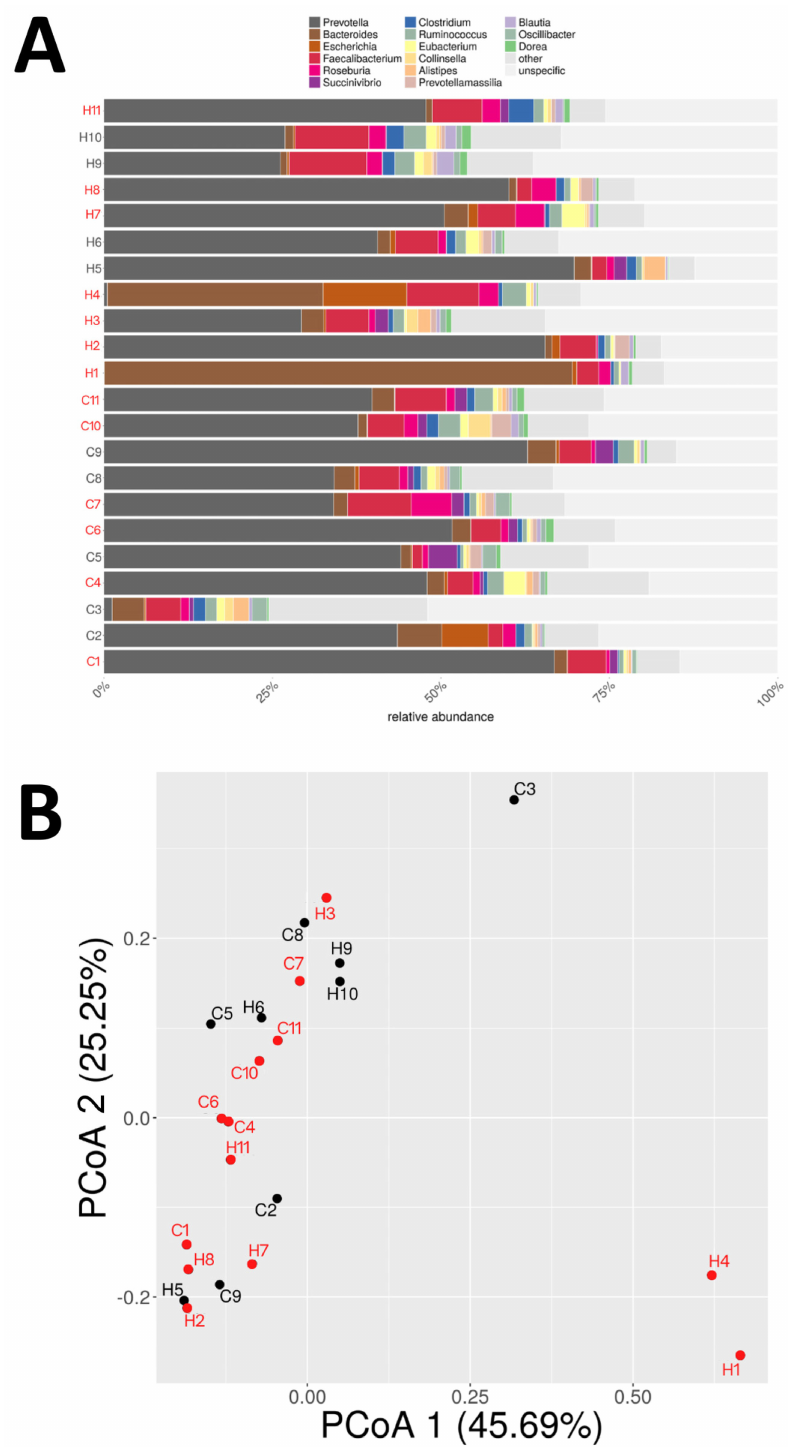
Figure 1. Gut microbiome profiles of Indonesian coastal and highland population exposed to mi- croplastics contamination. ( A ) Relative abundance of microbia associated with the stool samples of coastal and highland individuals at the genus level. ( B ) The principal component analysis of the samples based on the gut microbiota composition at the genus level. Abbreviations of samples: C—Coastal, H—Highland, sample code in red represents individuals with microplastic contamina- tion, while sample code in black represents individuals without microplastic